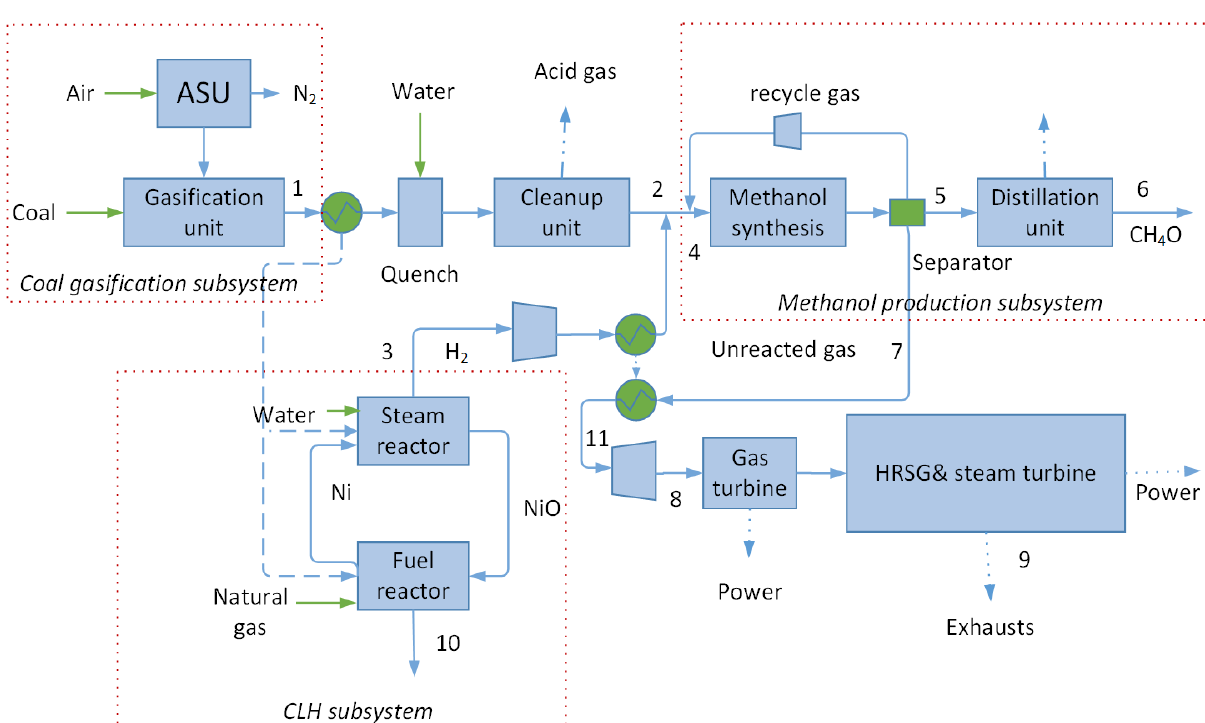
Figure 1 . Scheme of the multifunctional energy system